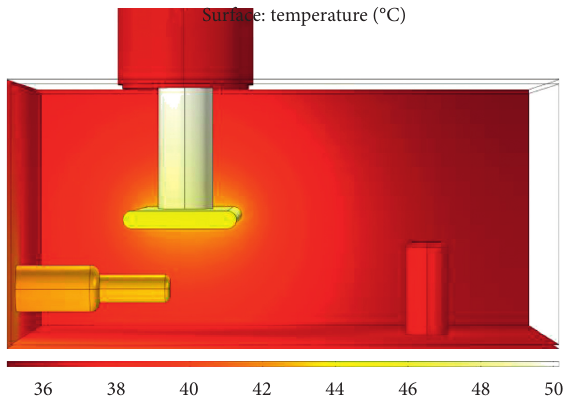
Figure 4: Surface temperature of steady-state thermal analysis. Cross section: electric field (V/cm)